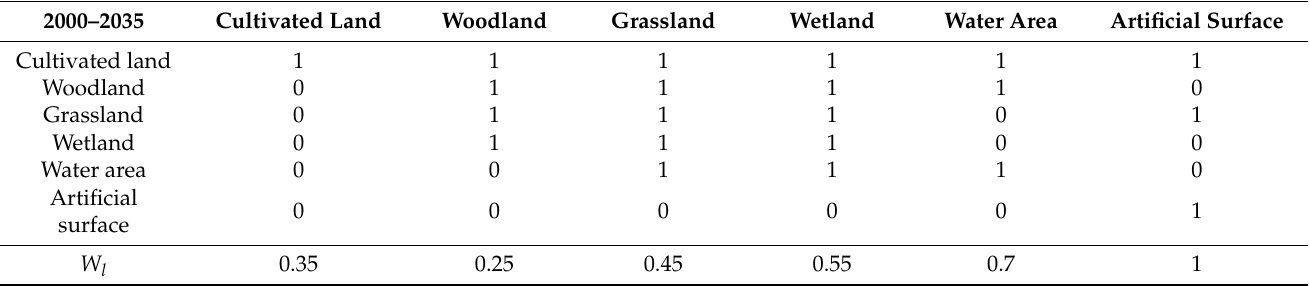
Table 2. Land conversion cost matrix and neighborhood influence factor